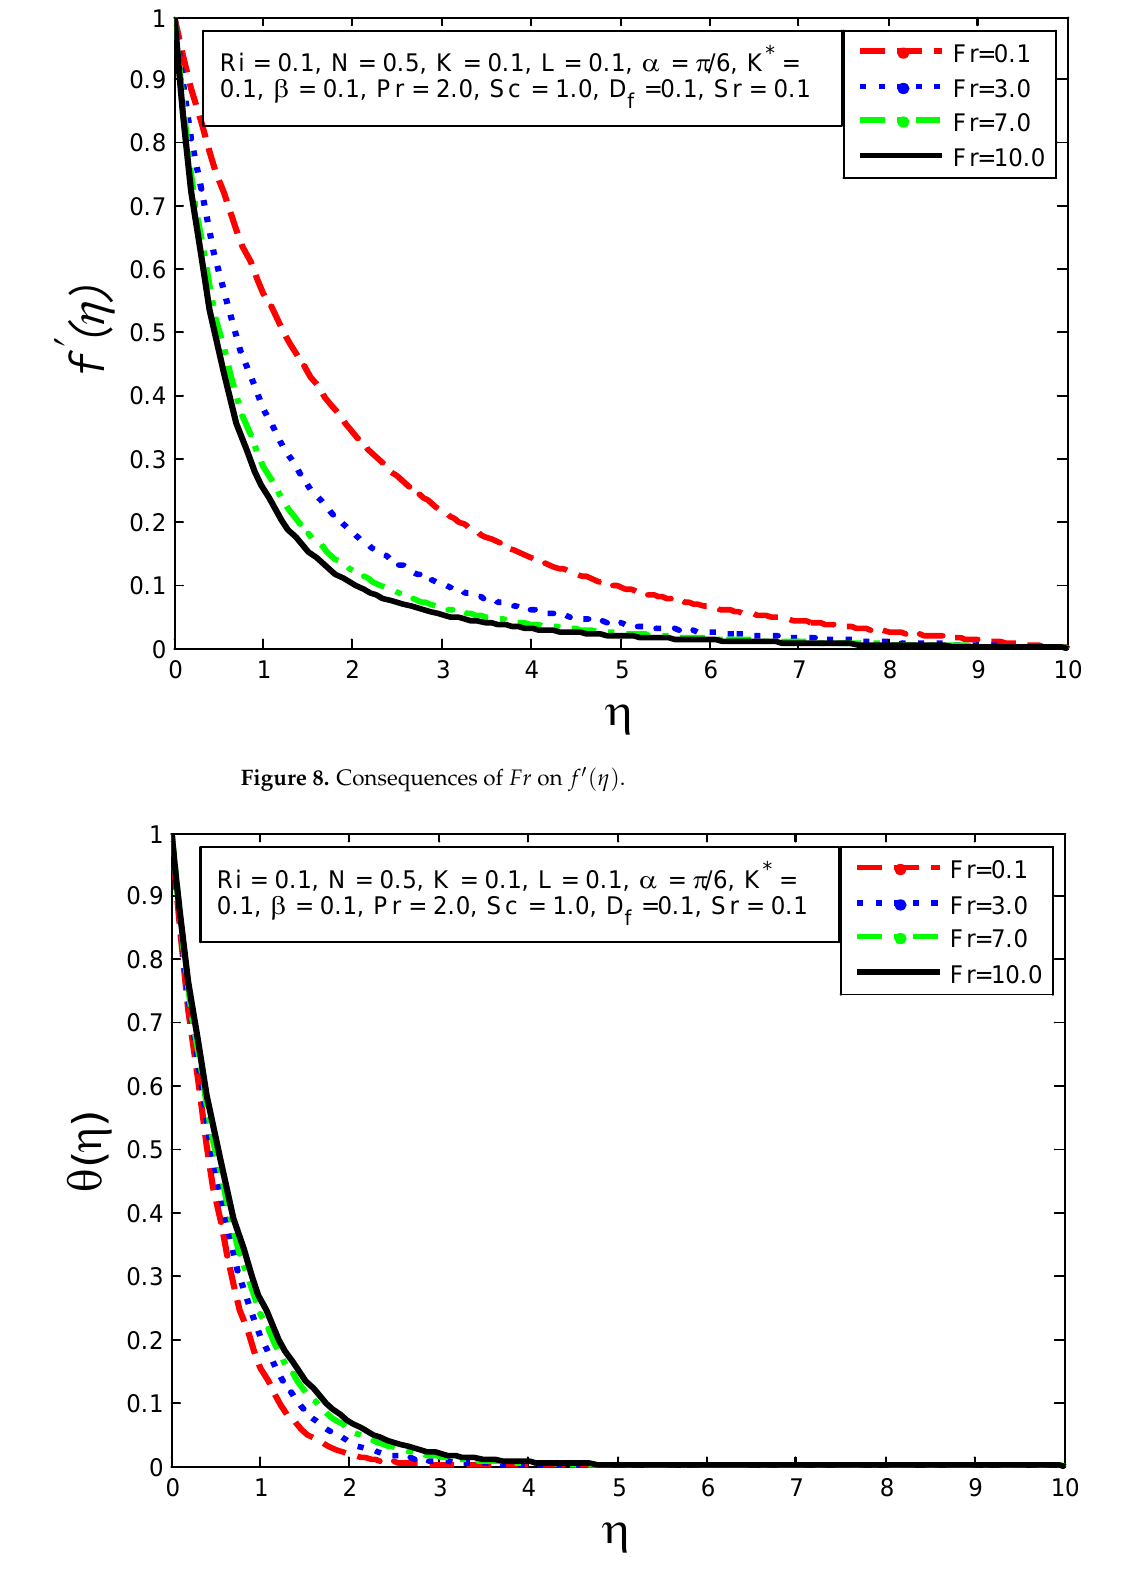
Figure 7. Consequences of